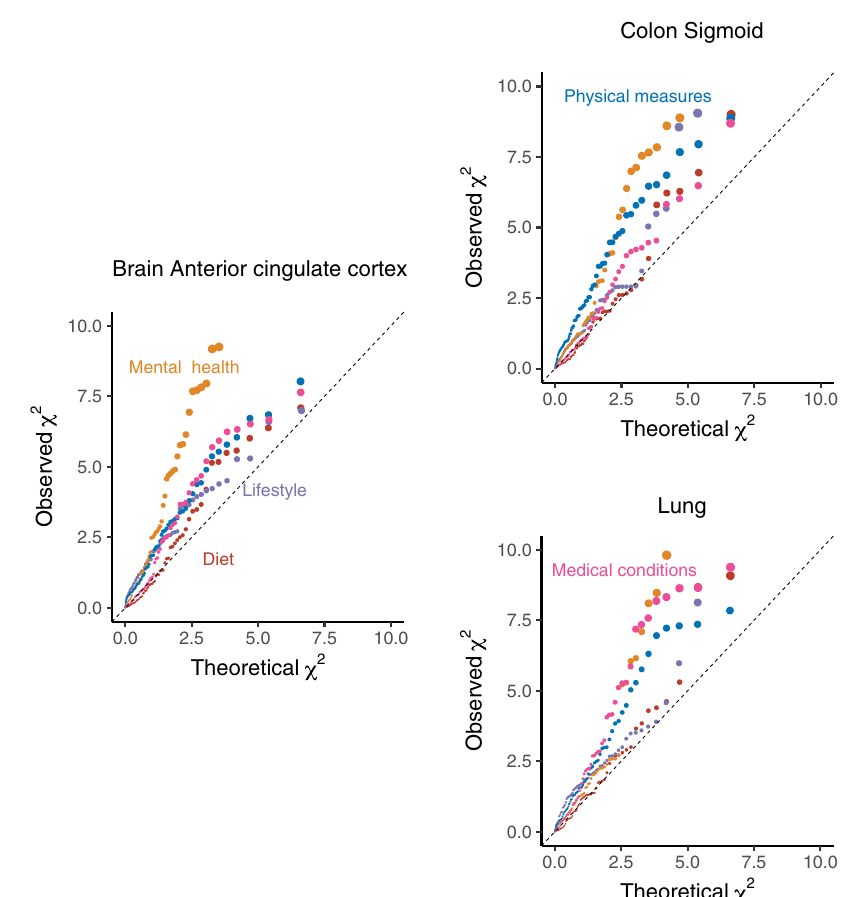
Fig. 4 Distribution of total genetic contribution assessment (TGCA) χ 2 statistic at cis -eQTL of speci fi cally expressed genes in three different tissues. The quantile-quantile plots compare the observed TGCA χ 2 statistics for ^ Θ at the cis -eQTL of top 100 speci fi cally expressed genes in each tissue. The expected null values were drawn from a χ 2 (1) distribution. Source data are provided as a Source Data fi